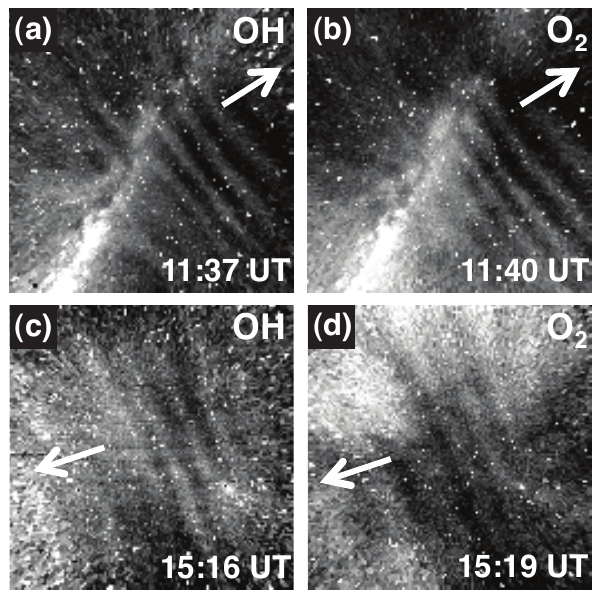
Fig. 1. Flat-fielded and unwarped airglow images obtained at Maui, HI, for the two case study events explored in this paper. Panels (a) and (b) depict OH and O 2 emissions, respectively, of Doppler-ducted wave observed on 5 July 2003. Panels (c) and (d) depict OH and O 2 emissions, respectively, of evanescent wave observed on 30 November 2003.